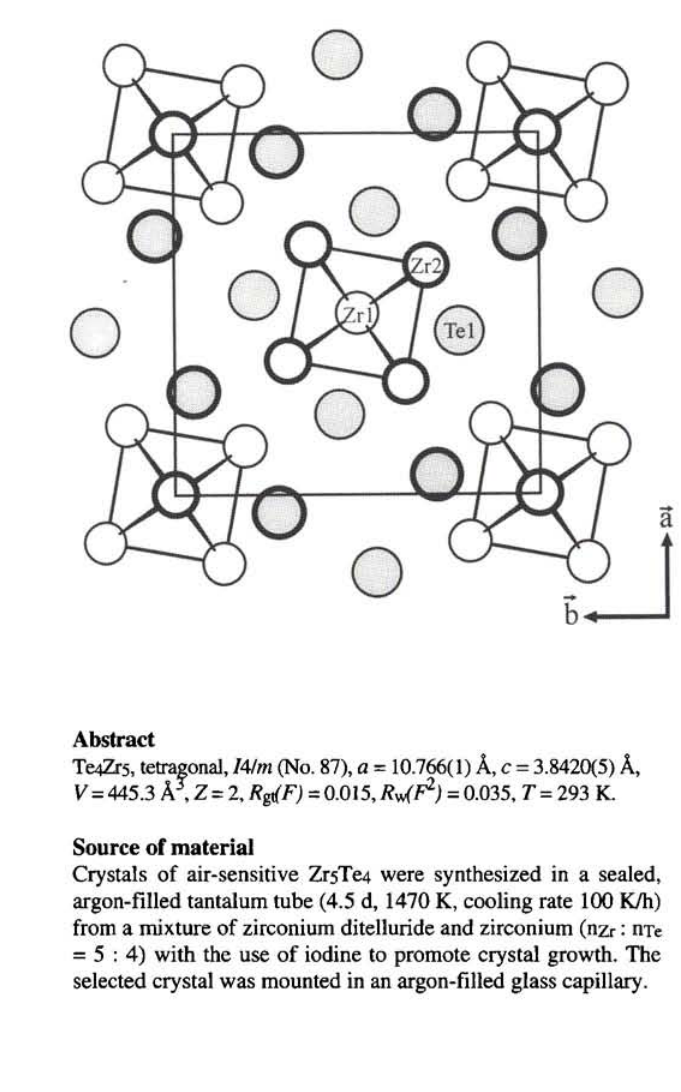
Table 2. Atomic coordinates and displacement parameters (in À 2